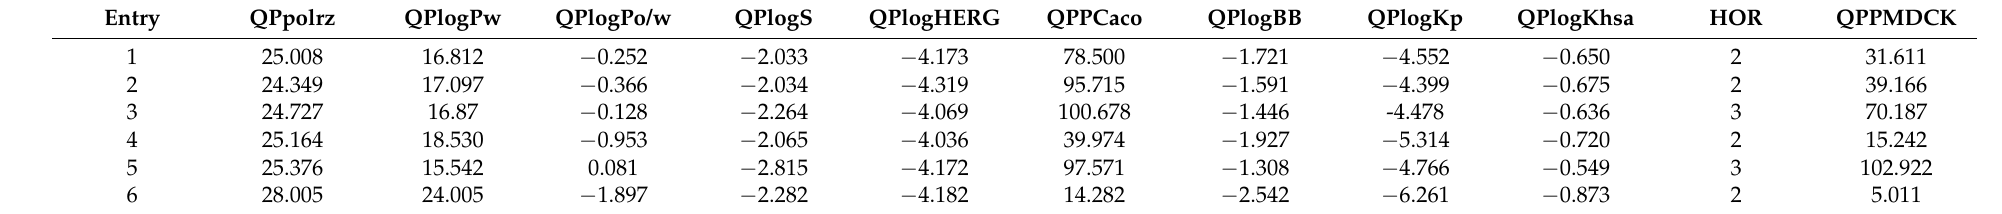
Table 3. Pharmacokinetic properties of the lead compounds and the reference compound using